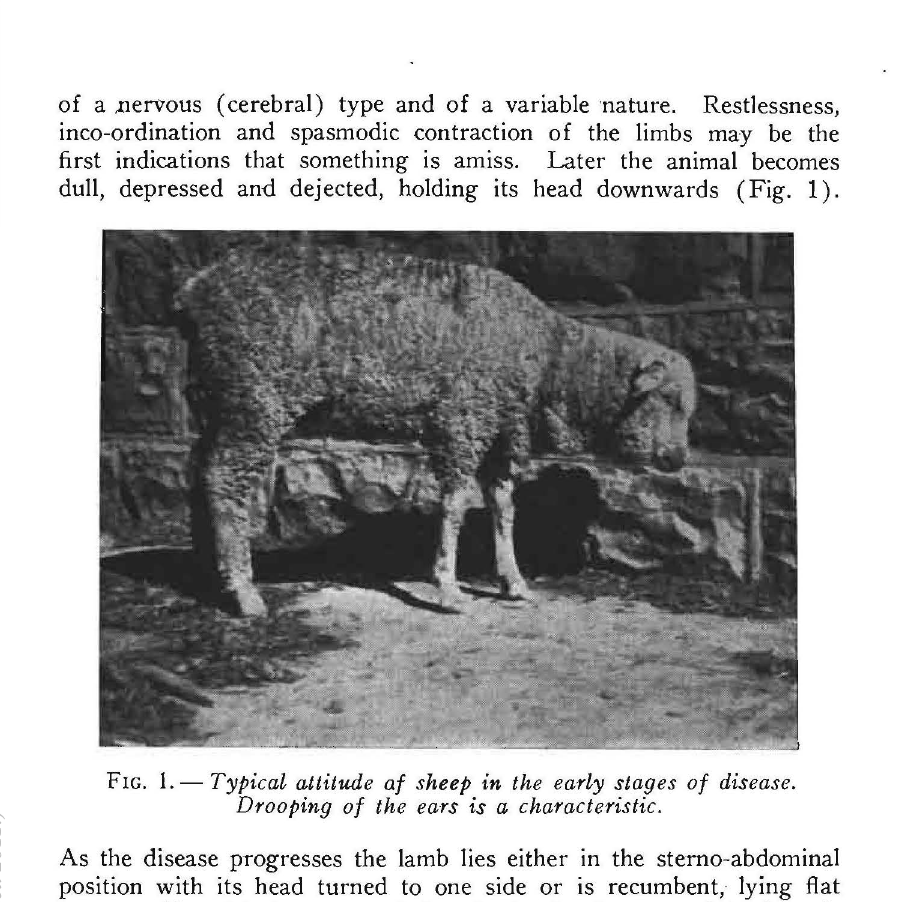
FIG. 1. - Typical attitude af sheep in the early stages of disease. Drooping of the ears is a